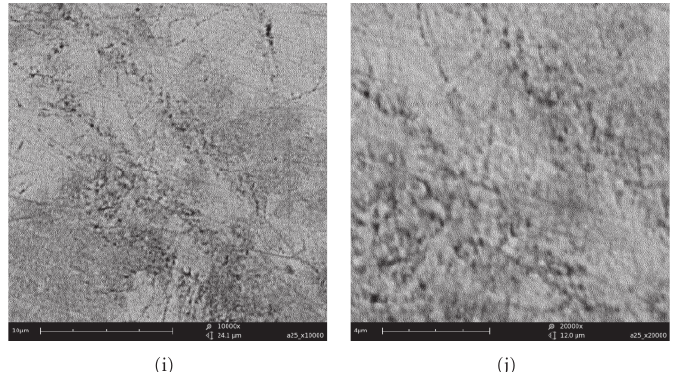
Figure 1: Scanning electron micrographs of enamel specimens after D2. (a) and (b) negative control; (c) and (d) 1400mg/L F; (e) and (f) 4500 mg/LF; (g) and (h) CPP-ACP product; (j) positive control. Scale bars represent 10 µ m ((a), (c), (e), (g), (i)) and 4 µ m ((b), (d), (f), (h),